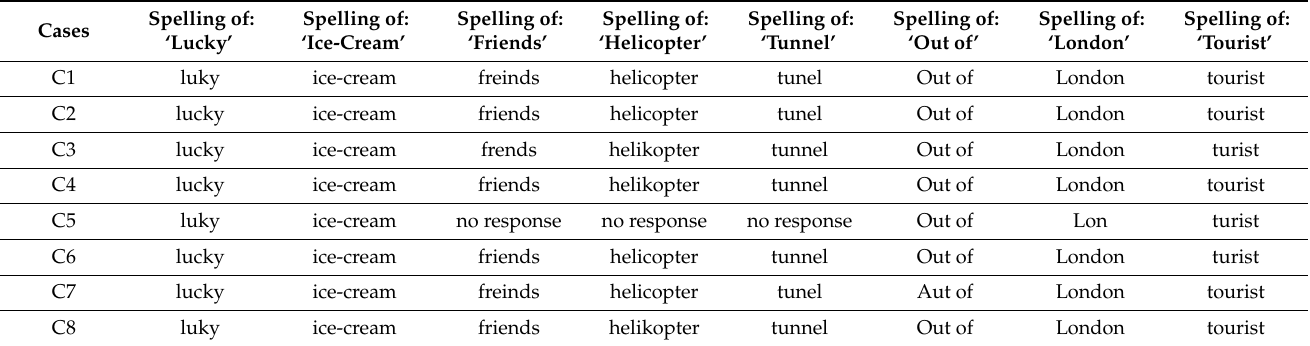
Table 4. Interview spelling